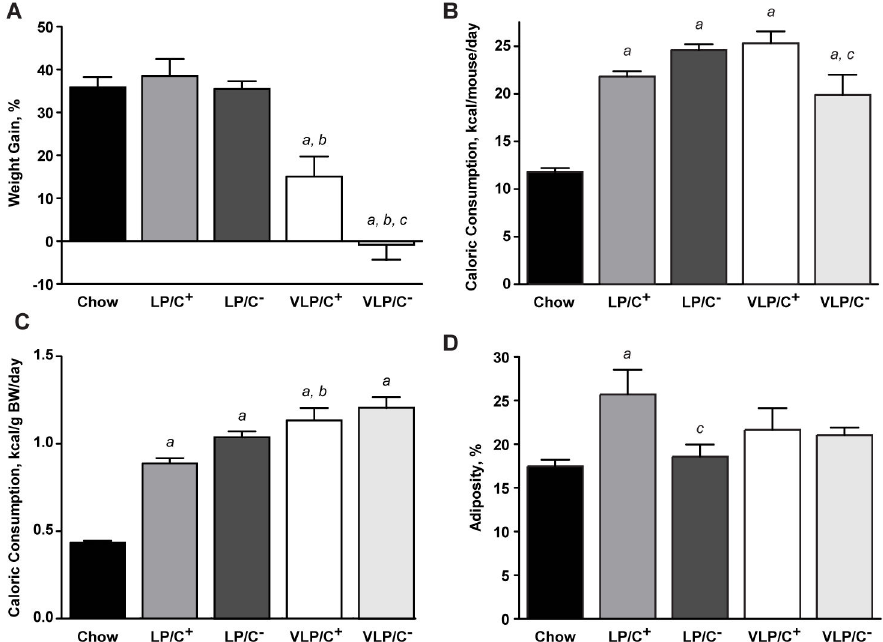
Figure 1. Metabolic parameters of mice maintained on very high fat, low protein, very low carbohydrate diets. ( A ) Body weight responses to 6 weeks of maintenance on the experimental paste diets, compared to chow controls. n=10-15 mice/group. a, p≤0.001; b , p≤0.001; c , p≤0.01. See end of this legend for description of the individual comparisons depicted by each letter. ( B ) Caloric consumption of diet, normalized per mouse, between weeks two and four of the 6 weeks of maintenance on the diets. n=5-10 mice/group. a, p≤0.001; c , p≤0.05. ( C ) Caloric consumption of diet, normalized per gram of body weight (BW). n=5-10